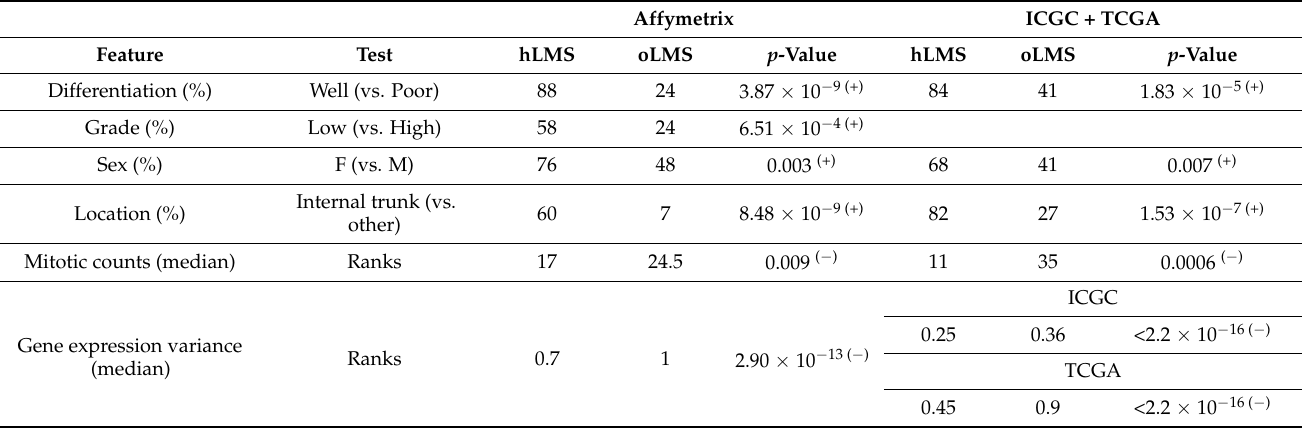
Table 1. Clinical enrichment and gene expression homogeneity in 42 hLMS vs. 56 oLMS from Affymetrix cohort and 73 hLMS vs. 29 oLMS in combined ICGC (28 vs. 11) and TCGA (45 vs.